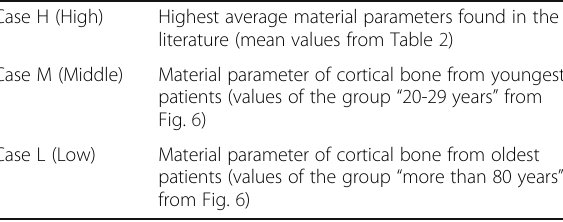
Table 3 The three different cases of the study